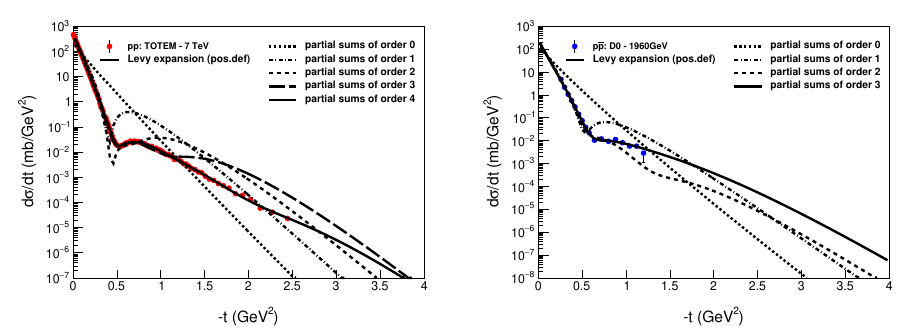
Figure 2. Partial sums from leading order to fourth order Levy expansion, as compared to the TOTEM data from Ref. [13] at √ s = 7 TeV pp (left) and to D0 data from Ref. [8] on pp elastic scattering at √ s = 1 . 96 TeV (right) elastic